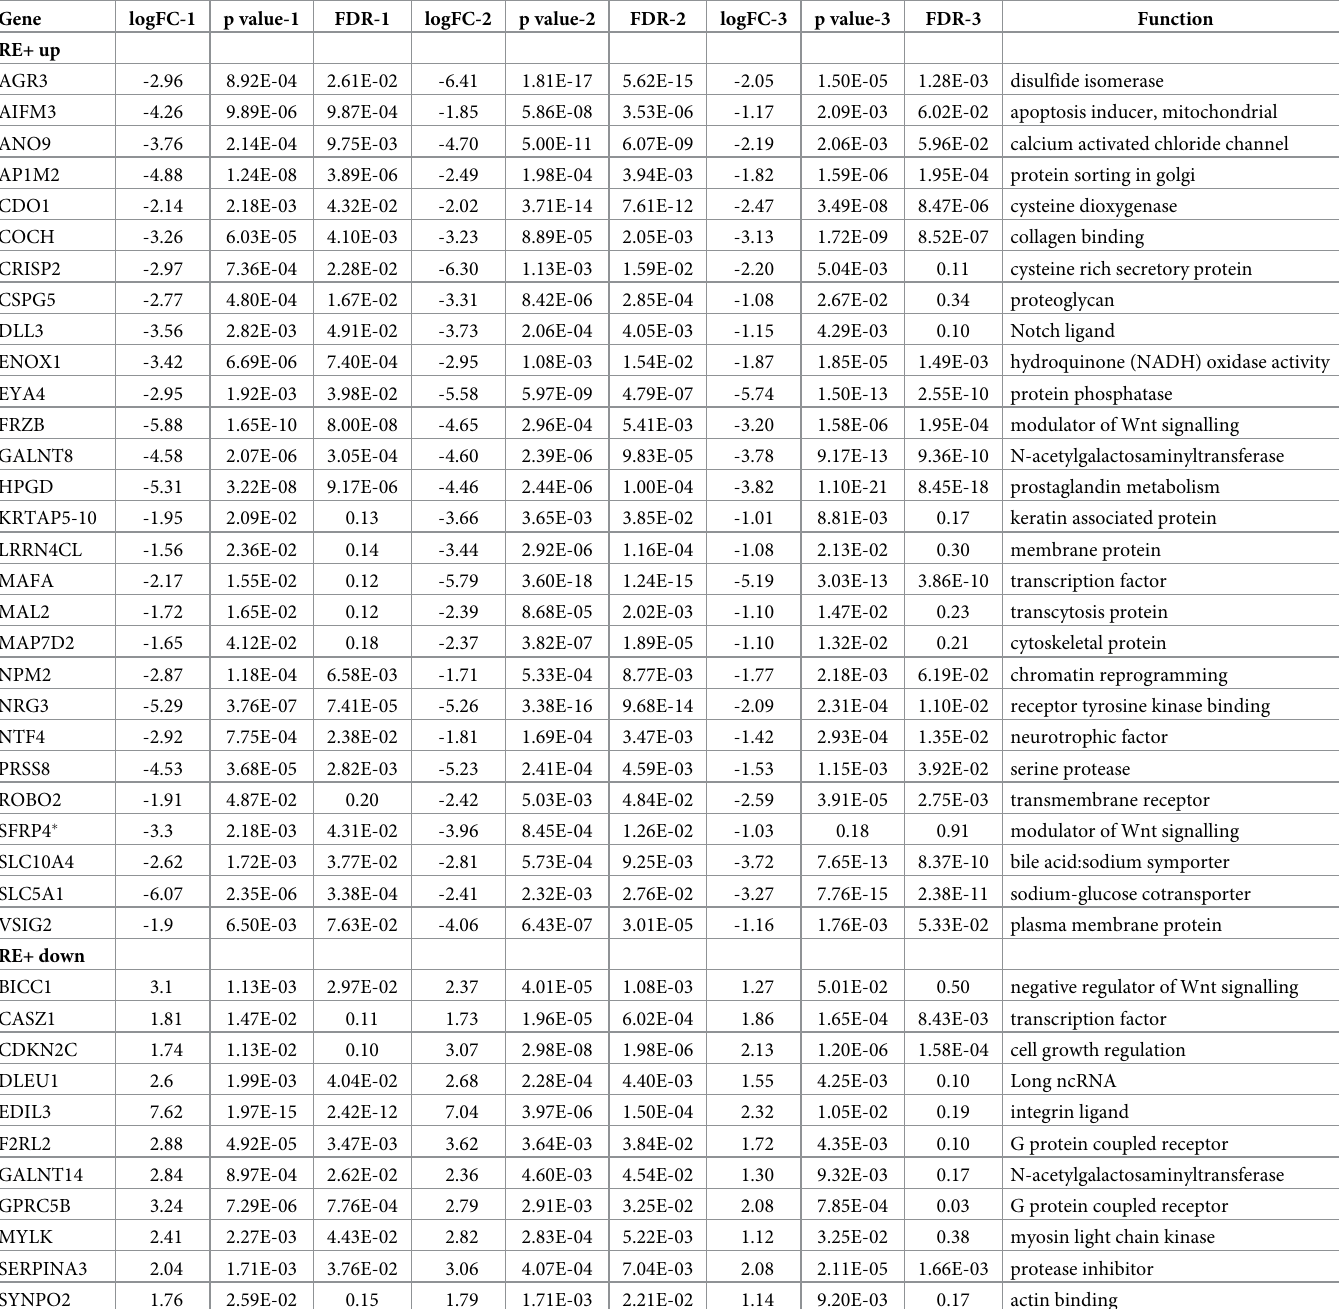
Table 4. Differential gene expression between RE+ and RE- corneal endothelial